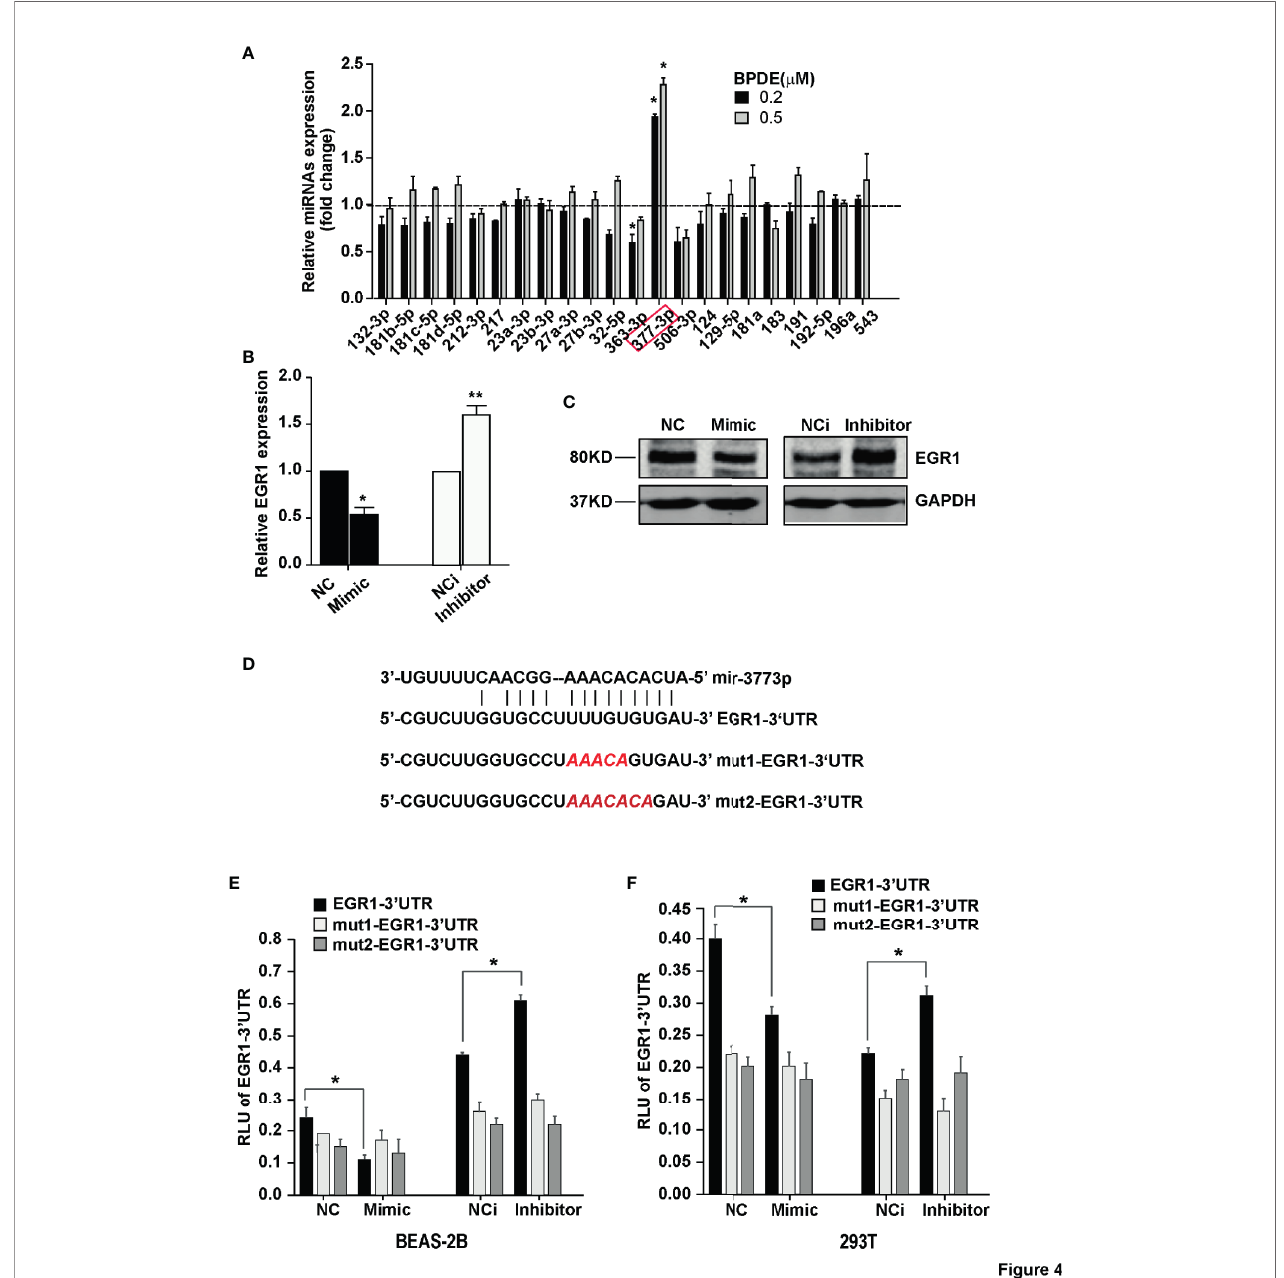
FIGURE 4 | MiR-377-3p activation mediated EGR1 inhibition following BPDE exposure. (A) Expression pro fi le of predicted miRNAs in BPDE-treated BEAS-2B cells by qRT-PCR. (B, C) EGR1 expression after transfection of miR-377-3p mimic and inhibitor in BEAS-2B cells was analyzed by QRT-PCR and Western blot. (D) The putative target site of miR-377-3p in the 3 ’ UTR of EGR1 (upper panel); red letters indicate the mutant luciferase reporter gene sequence (lower panel). (E, F) EGR1 3 ’ UTR luciferase reporter assays in BEAS-2B cells and 293T cells. The analyses were repeated three times, and the results were expressed as mean ± SD. * P < 0.05 and ** P <